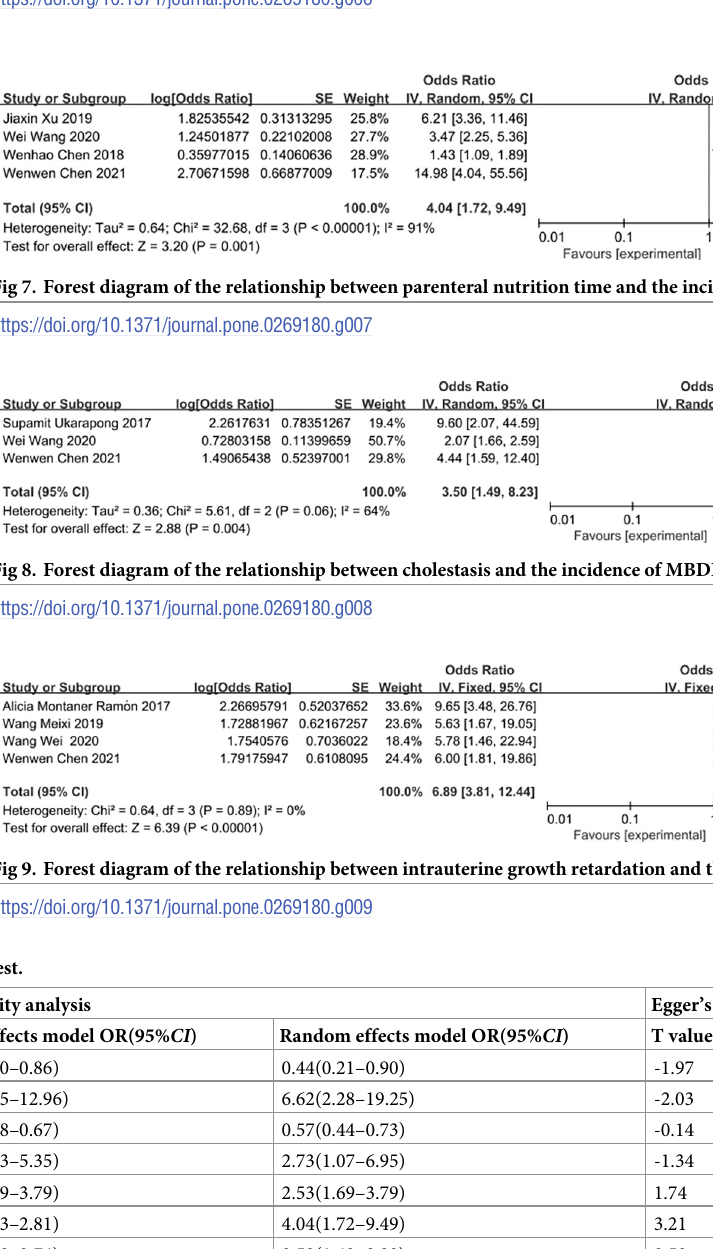
Fig 6. Forest diagram of the relationship between septicemia and the incidence of MBDP.